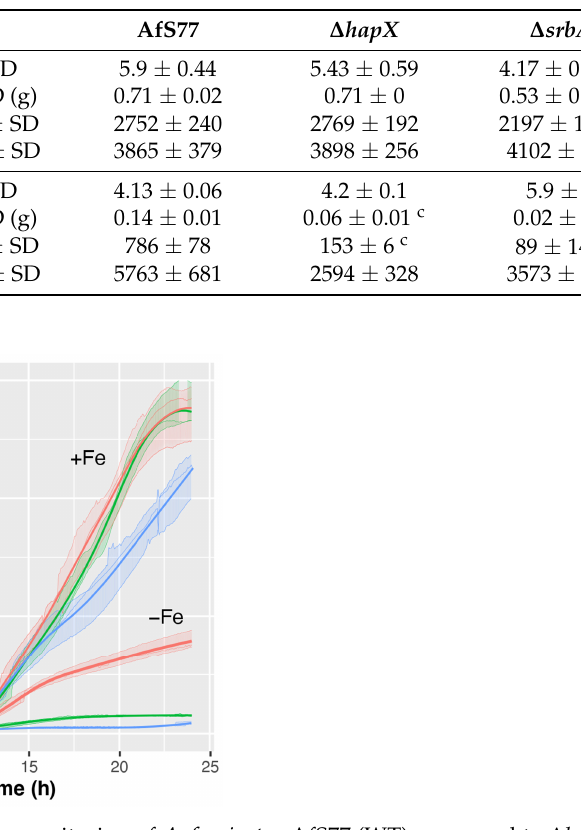
Table 4. DW, BS values, BS/DW ratios, and pH values of A. fumigatus AfS77 compared the ∆ hapX and ∆ srbA mutant strains cultured for 24 h under +Fe and − Fe conditions. Mean ± standard deviation of biological triplicates is displayed. Statistically significant differences (marked by a , b , or c ) of mutant strains compared to AfS77 were assessed by one-way ANOVA and Tukey’s multiple comparison test.